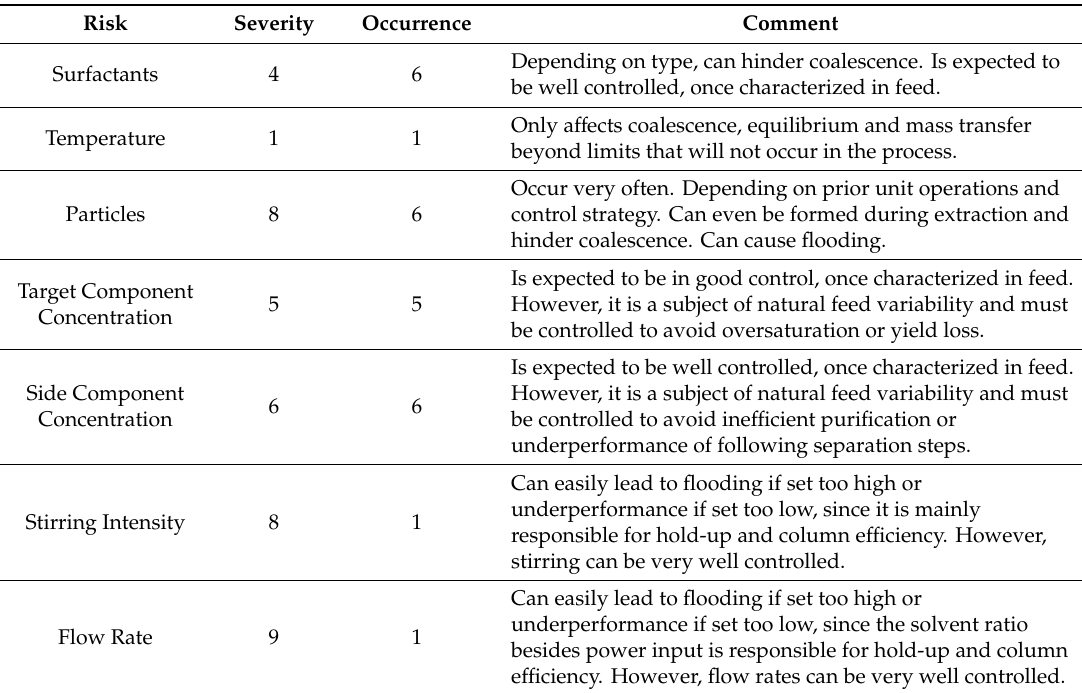
Table 1. The failure-mode-e ff ect-analysis (FMEA) for the process development of a stirred extraction column is derived by scoring the range of possible critical process parameters (CPPs), identified in the Ishikawa diagram, regarding the possible impact that an occurring risk will have on quality attributes and the possibility that the risk will